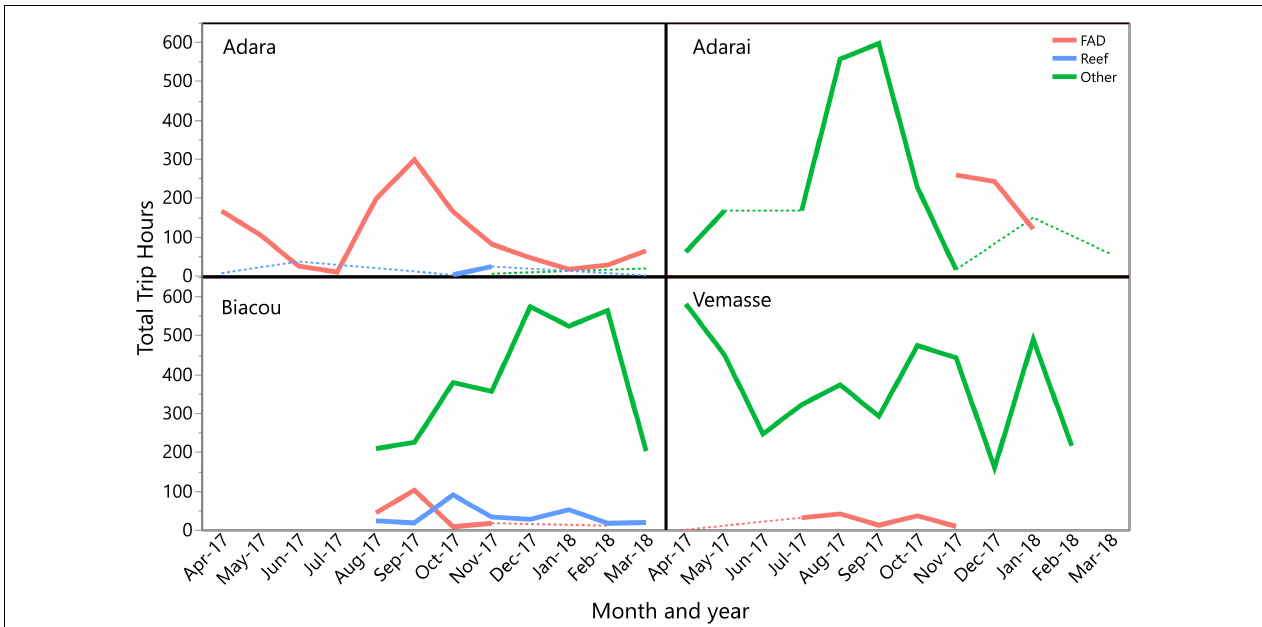
FIGURE 2 | The total number of fishing trips for which catch was recorded, by month and habitat at four sites in Timor-Leste. Solid lines represent continuous data. Connecting dotted lines reflect no